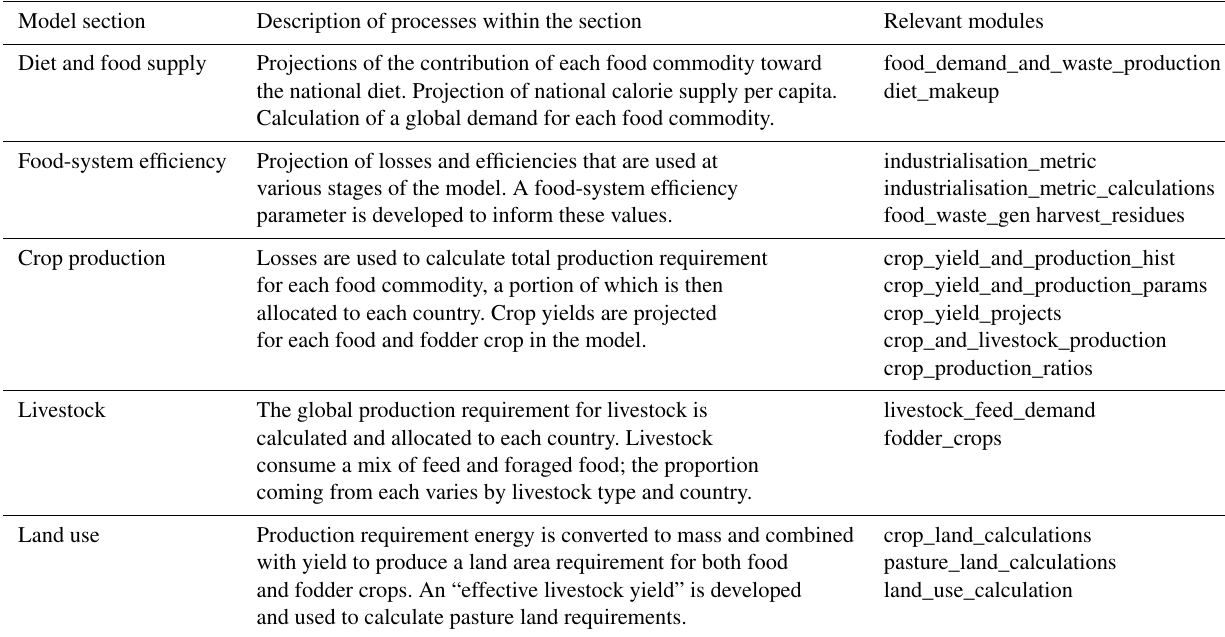
Table A1. Five main sections within C-LLAMA, each comprised of a handful of model process modules. There are 16 model process modules in total. There is some overlap between model processes; the sections and model process modules listed here are not necessarily in the order that they appear in C-LLAMA; some sections are re-visited at later stages of the model. The first section of the model produces a food supply at a national level, disaggregated into calories and commodities.